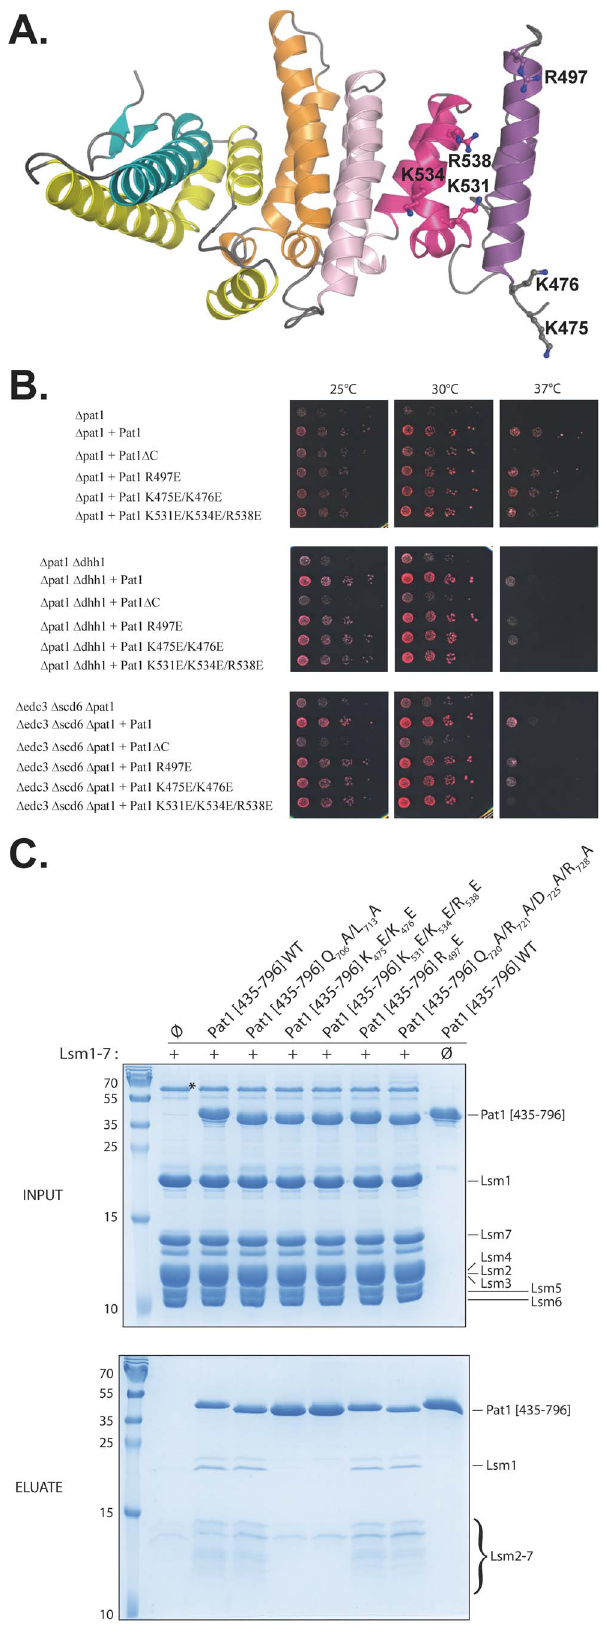
Figure 3. The conserved residues at the N-terminal residues are involved in interaction with Lsm1-7. A. ScPat1C structure with the residues mutated in this study shown as ball and sticks. Color scheme identical to Fig.1A. B. Growth analysis of PAT1 mutants. Serial dilutions of the different strains transformed with vector, a plasmid encoding wild type ScPat1, or the indicated mutant thereof, were deposited on plates and incubated at the indicated temperatures. C. Pull-down experiment of untagged Lsm1-7 complex with His 6 ScPat1C wild type or mutants. Input (top) and eluted (bottom) samples were analyzed by 22% SDS-PAGE and Coomassie Blue staining. The asterisk denotes a contaminant protein that co-purifies with the Lsm1-7 complex but which is not retained on the HisPur TM Ni-NTA Magnetic Beads used for these pull-down experiments. Molecular weights (kDa) of the markers are indicated on the left of the